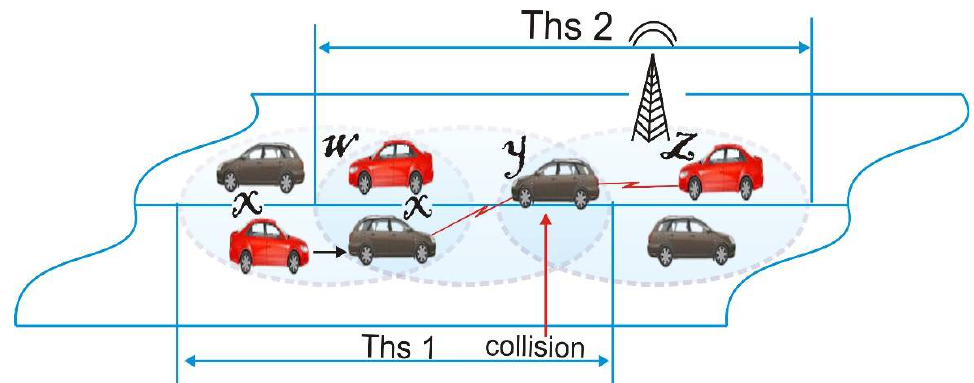
Figure 2. Merge collision due to node mobility [20]. Note: THSO is the ratio of a THS’s necessary time slots to the total number of time slots available for that THS.